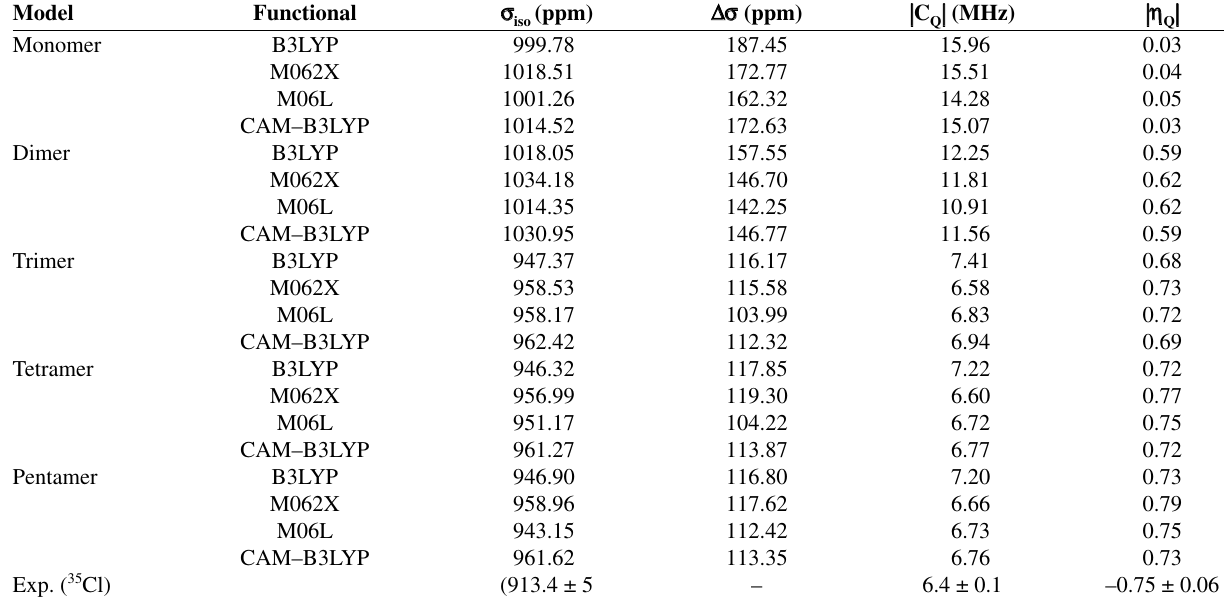
Table 1. Calculated chlorine-35 quadrupolar and chemical shift data for various Alanine hydrochloride clusters.